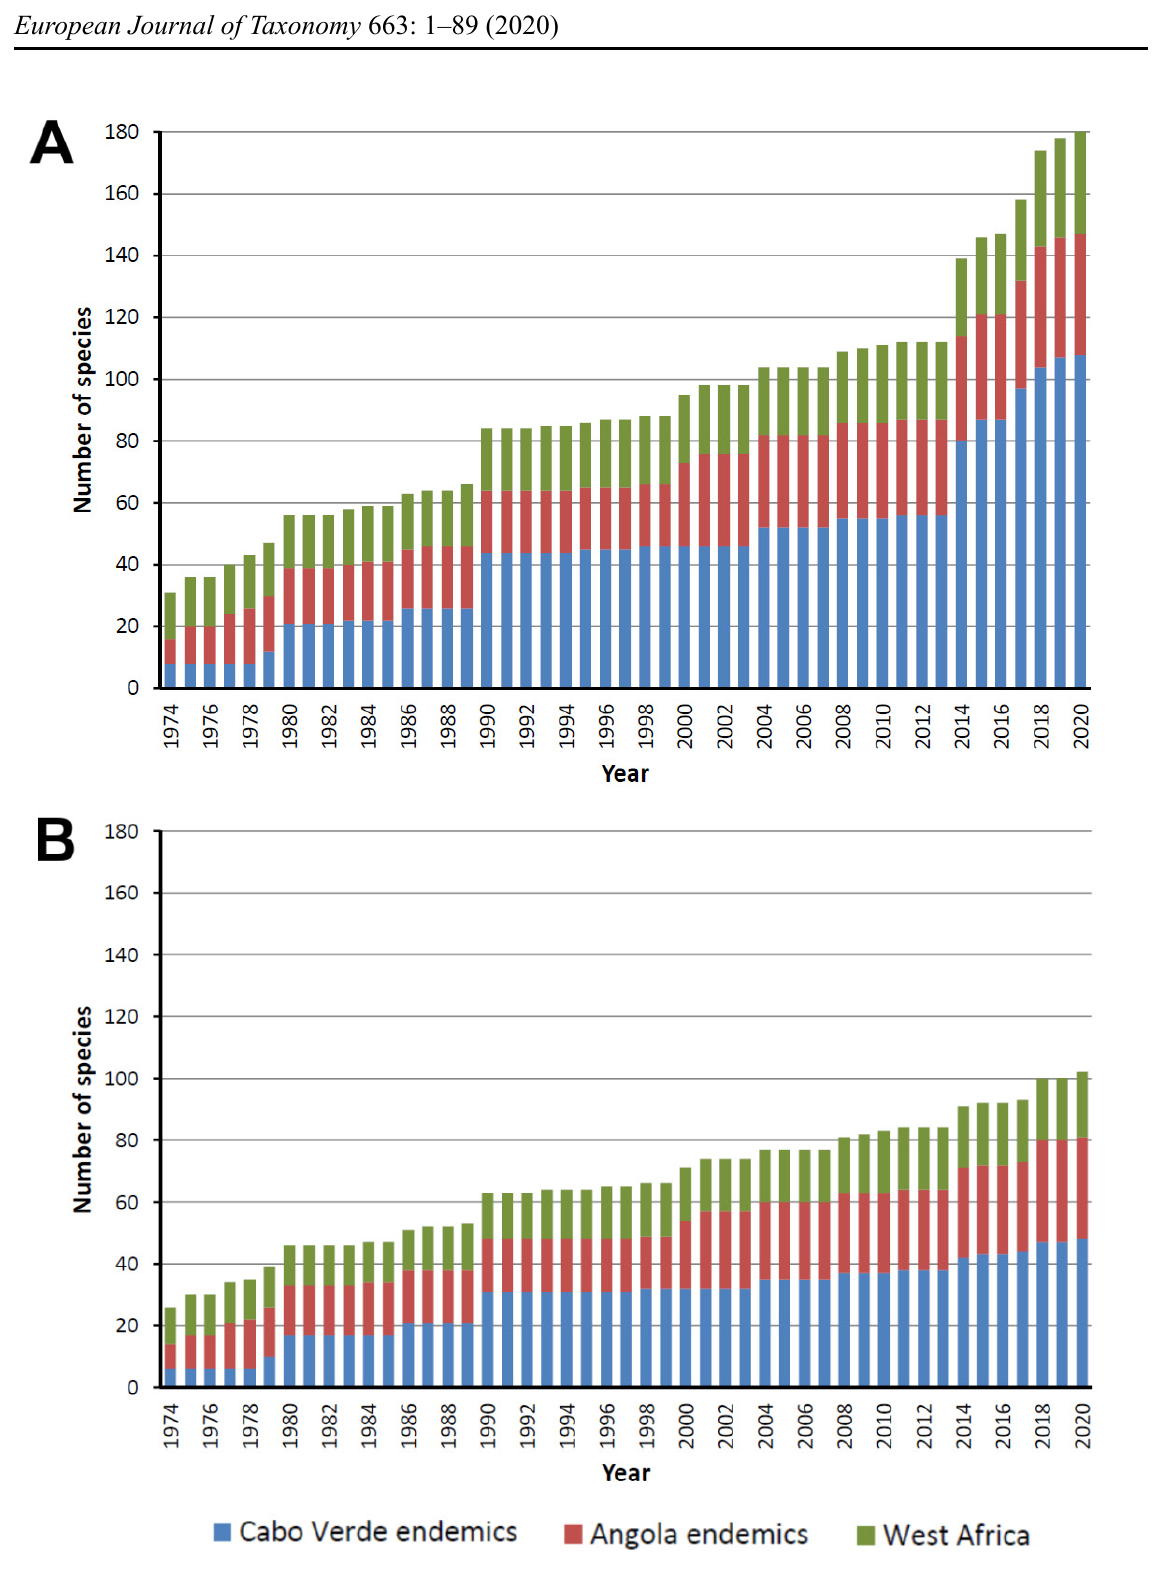
Fig. 12. Stacked bar charts of the accumulated number of species described in the period 1974–2020 before (A) and after (B) revision, showing the contribution to the total number of species of the Cabo Verde endemics (blue), Angola endemics (red) and the remaining species from West Africa (green). Note that Angolan cone endemics still await a thorough genetic